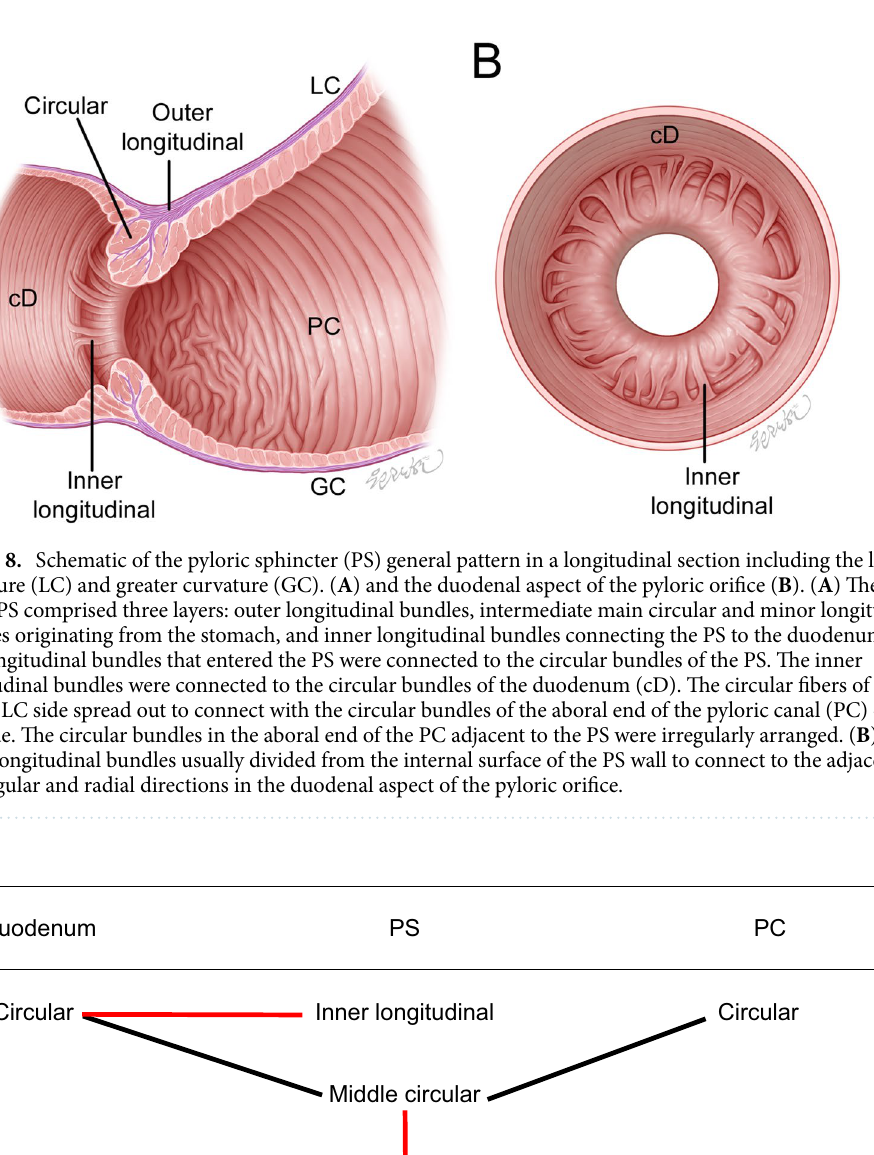
Middle circular